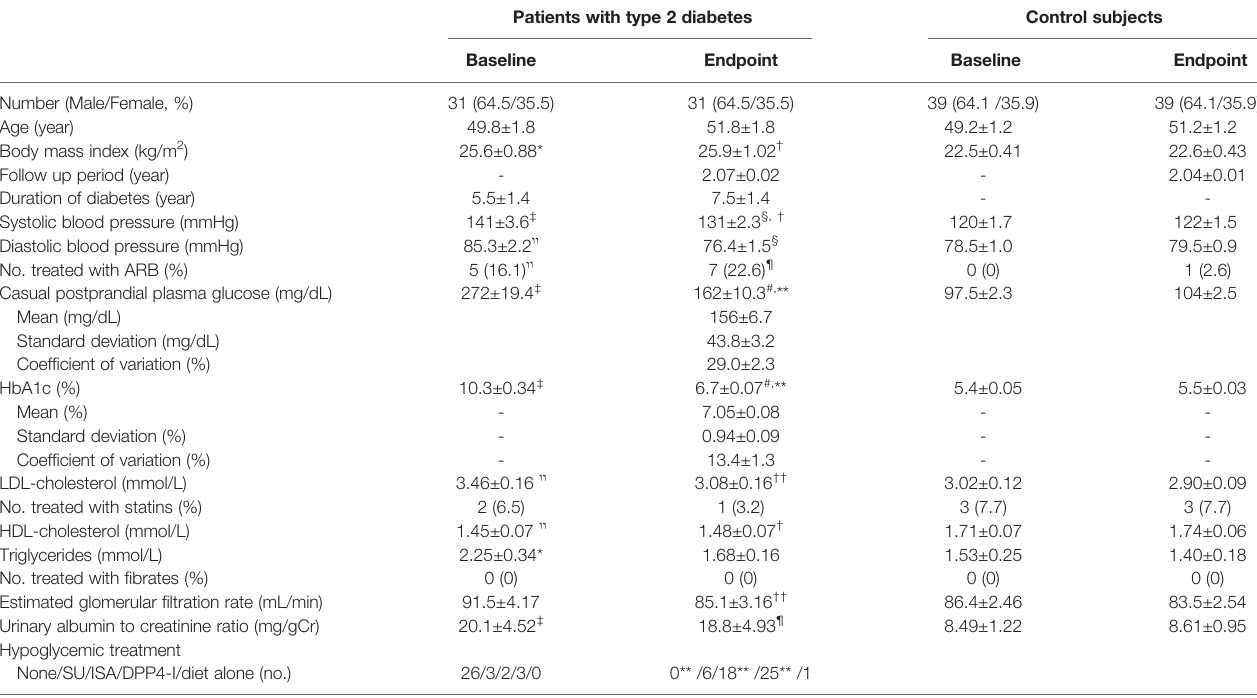
TABLE 1 | Demographic data and clinical characteristics at baseline and endpoint in patients with type 2 diabetes and control subjects.